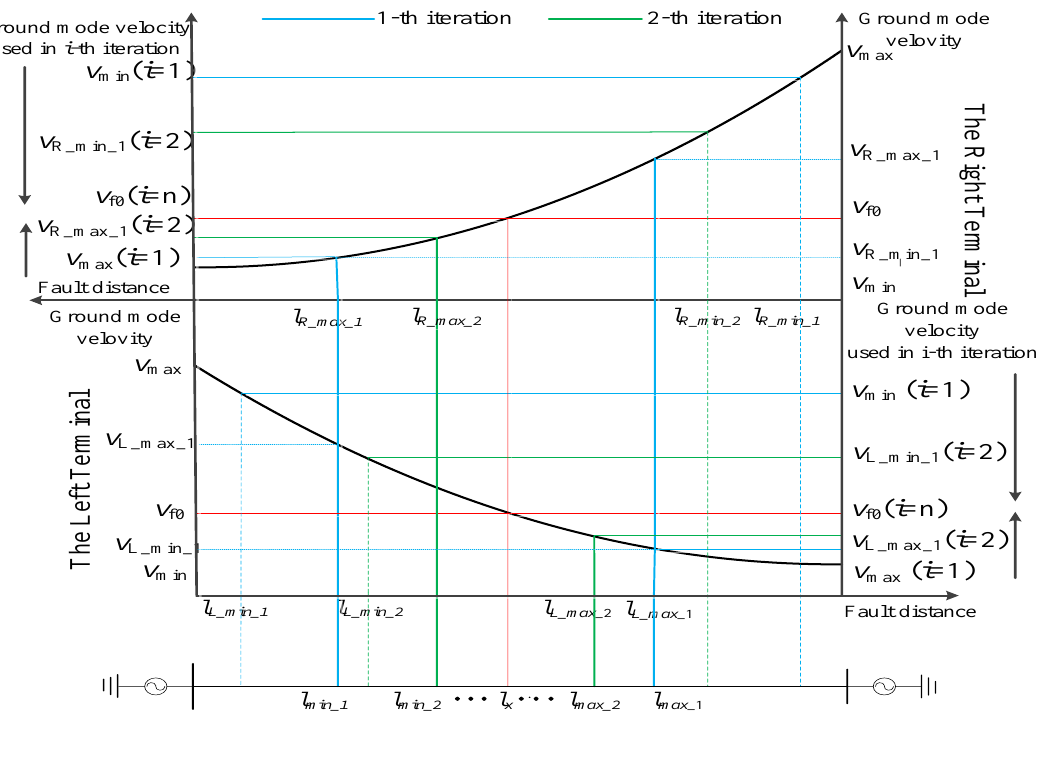
Figure 8. The fault location process.